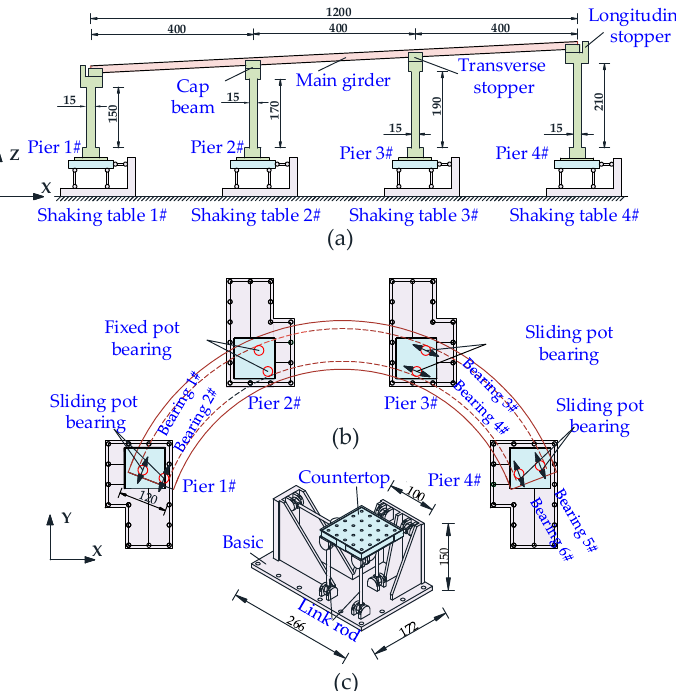
Figure 3. Bridge structure model layout (unit: cm): ( a ) elevation view, ( b ) plan view, ( c ) shaking table details. Table 2. Performance parameters of shaking table. Table Size of Shaking Table